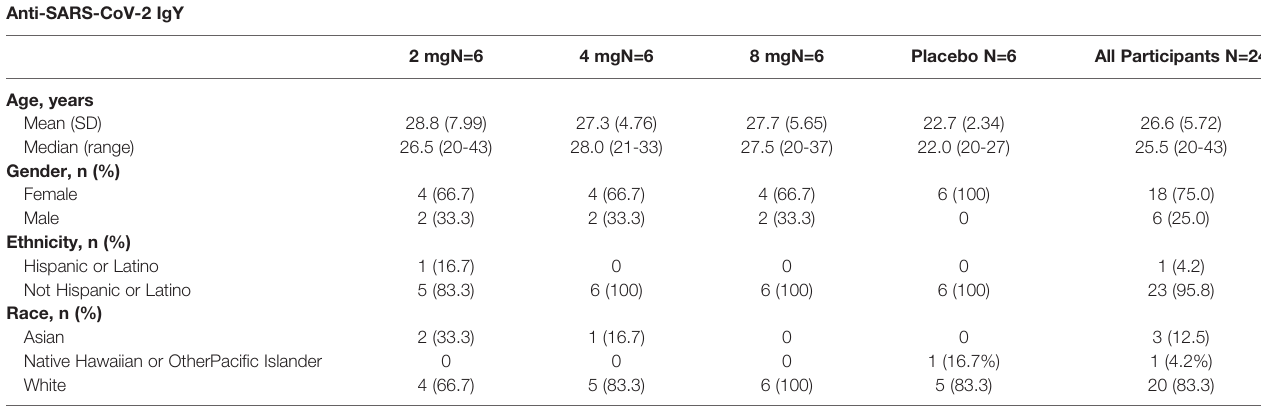
TABLE 1 | Demographics of participants in single-ascending dose group (Part 1).